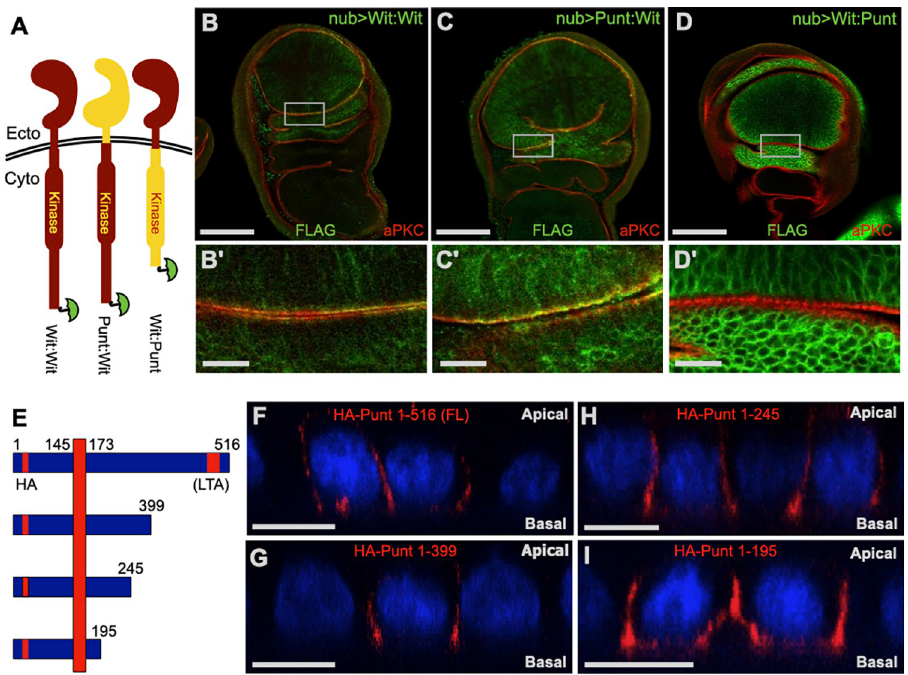
Fig 2. Basolateral localization of Punt is conserved in MDCK cells and maps to a short region of the cytoplasmic domain. (A–D) Chimeric proteins of Punt and Wit map the BLT activity to the cytoplasmic domain of Punt. The chimeric proteins comprise the extracellular and TM region (Ecto) and the cytoplasmic (Cyto) regions of the indicated proteins, with a c AU : Pleasenotethatasperstyle ; thetermcarboxyl (cid:0) terminalshouldbeusedwhenitfunctionsasanadjectiveinasentence : arboxyl-terminal FLAG epitope (green umbrella symbol) for detection by IF. Wit:Wit staining overlapped with the apical marker (B), as did staining for the Punt:Wit chimera (C). TheWit:Punt chimera displayed basolateral distribution (D). Single prime ( 0 ) images show boxed areas at higher magnification. (E–I) Fly Punt expressed in polarized mammalian MDCK cells displayed basolateral localization, but does not require the same region as T β RII. A schematic shows the features of Punt relative to the plasma membrane (E). The amino-terminal ectoplasmic portion is separated from the cytoplasmic domain by the vertical bar indicating the plasma membrane. The HA tag and the corresponding position of the LTA motif are shown in red, with numbers indicating FL Punt and truncation positions. (F–I) xz projections from confocal images of intact epithelium transiently expressing HA-Punt constructs, with apical to the top of each image, as indicated. Nuclei are stained with DAPI (blue) and surface receptors are stained with anti-HA (red). FL Punt and variants harboring deletions of extended segments of the cytoplasmic domain were all detected at the basolateral membrane but excluded from the apical membrane. See S2 Fig for additional deletion constructs that retain basolateral distribution. Scale bars: 100 μ m for B, C, D; 15 μ m for B 0 , C 0 , D 0 ; 25 μ m for F–I (scale varies slightly for xz projections in F–I). BLT, basolateral targeting; FL, full length; MDCK, Madin- Darby canine kidney; TM, transmembrane